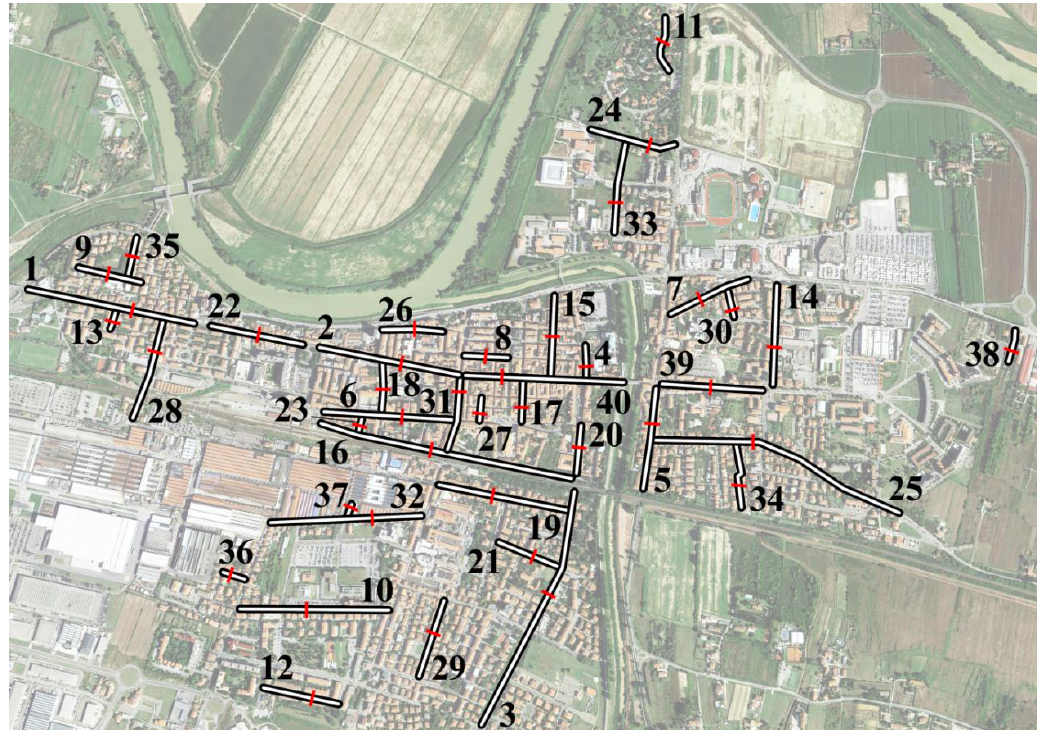
Figure 6. Location of the 40 roads in which the traffic volumes have been observed (the sections adopted for the traffic volumes observations campaign are shown with red lines).